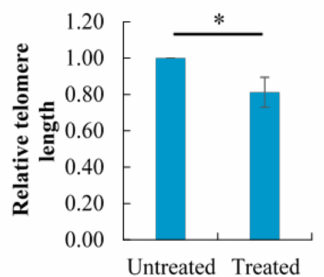
Figure 8. Effect of 10.54 µ g/mL berberine-treated HCT 116 at 48 h on the relative telomere length. Changes in telomere length are expressed as fold change relative to untreated HCT 116 at 48 h. Values are mean ± standard error of octuplicate. Mean with * (single asterisk) differ significantly at p <